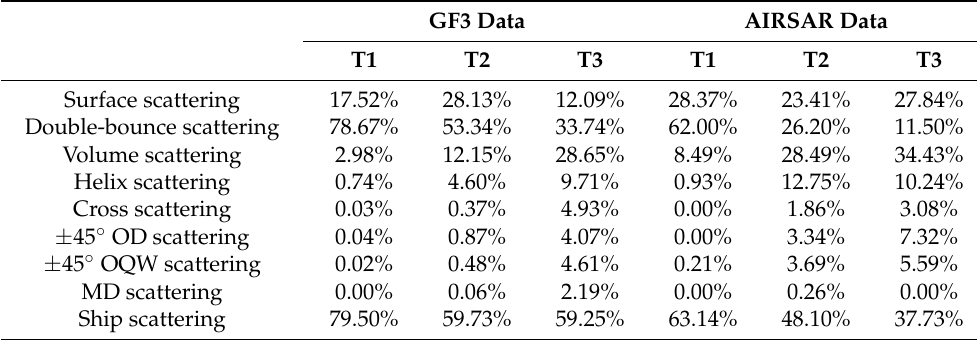
Table 2. Scattering Contribution Statistics for